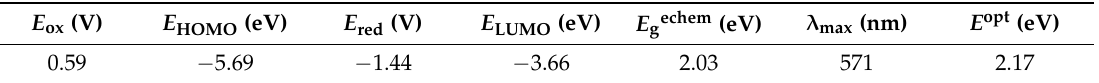
Table 1. Cyclic votammetry (CV) and UV-vis data of 5,5 (cid:48) -bis[5-(9-decyl-9 H -carbazol-3-yl)thien-2-yl]-4 H ,4 (cid:48) H - [3,3 (cid:48) -bi-(1,2,6-thiadiazine)]-4,4 (cid:48) -dione ( 7 ). All the values correspond to peak